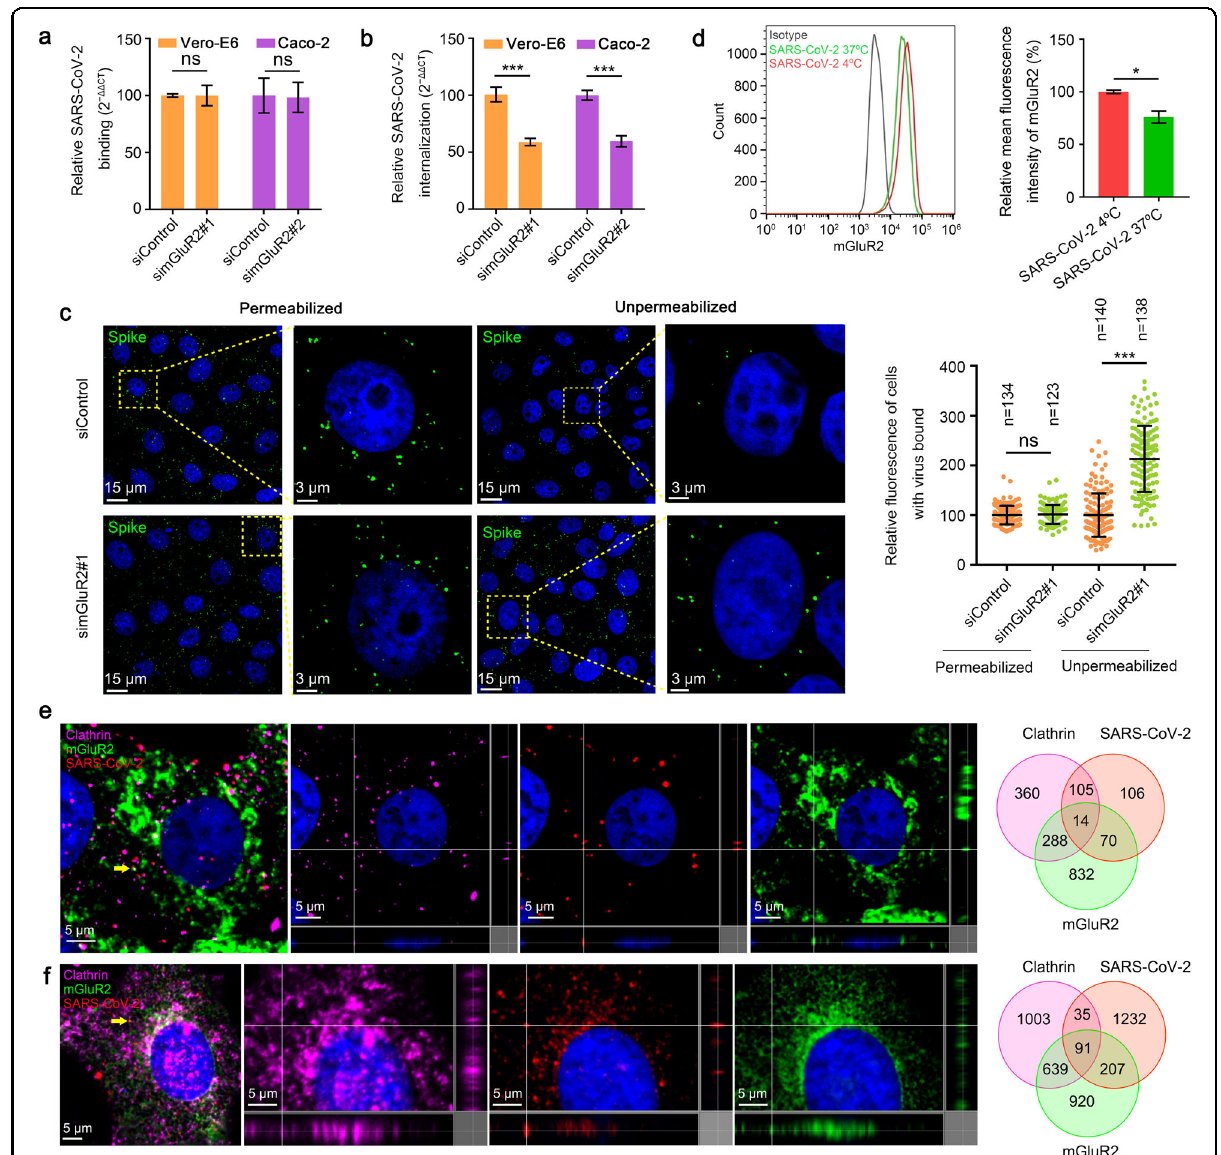
Fig. 2 mGluR2 is required for internalization of SARS-CoV-2 but not for cell binding. a , b SARS-CoV-2 binding ( a ) and internalization ( b ) assays were performed in mGluR2-silenced Vero-E6 cells and Caco-2 cells. Viral binding or internalization was quanti fi ed by normalization to the respective scrambled siRNA-transfected cells. c Vero-E6 cells were treated as described in a , except they were not treated with acid buffer/trypsin. Cell nuclei (blue), SARS-CoV-2 S protein (green). Left: representative images are shown, and the dashed box is magni fi ed at the indicated location of the same image. Right: the fl uorescence signal of SARS-CoV-2 particles was quanti fi ed by immuno fl uorescence staining using ZEN software. The relative fl uorescence of cell-bound HRB25 under permeabilized or unpermeabilized conditions was quanti fi ed by normalization to the corresponding scrambled siRNA-transfected cells. The circles represent individual data points. n , the number of quanti fi ed cells. Data represent the sum of three independent experiments. d Surface expression level of mGluR2 was detected by using fl ow cytometry after infection with HRB25 at 37 °C for 30 min under unpermeabilized conditions in Vero-E6 cells. e , f Multiplex immuno fl uorescence was performed in Vero-E6 cells ( e ) and HPAE cells ( f ). Colocalization of mGluR2 (green), SARS-CoV-2 N protein (red), and clathrin (purple) was observed and quanti fi ed. The yellow arrows indicate the representative colocalization of mGluR2 (green), SARS-CoV-2 N protein (red), and clathrin (purple), shown in three dimensions. The data shown are representative results from three independent experiments ( a , b , d n = 3), means ± SD, Student ’ s t -test, ns, not signi fi cant, *P < 0.05, ***P <